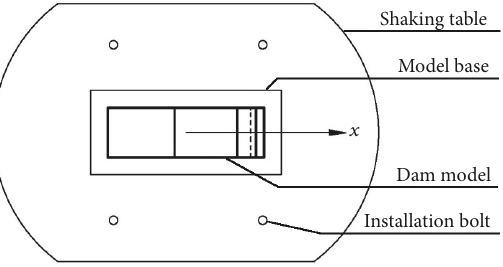
Table 4: Shaking table technical parameters.